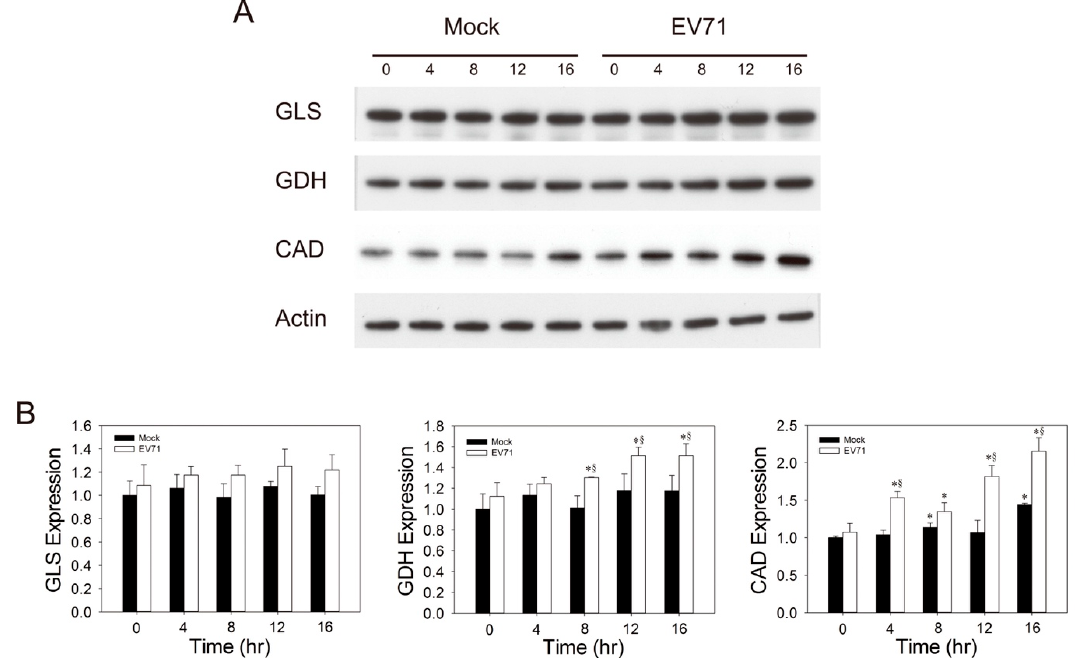
Figure 6. Increased expression of GDH and CAD proteins during viral infection. ( A ) Vero cells were mock- (Mock) or infected with virus ( EV71 ) at MOI of 1.25, and were harvested at the indicated time-points p.i. for western blotting with antibodies to GLS, GDH, CAD and actin. A representative result of three experiments is shown. ( B ) The expression levels were quantified by densitometry and Image J software and normalized to that of actin, and are expressed as fold change relative to that of mock-infected cells at 0 h p.i. * p < 0.05, significant difference from cells at 0 h; § p < 0.05, significant difference from mock-infected cells at the same time-points.